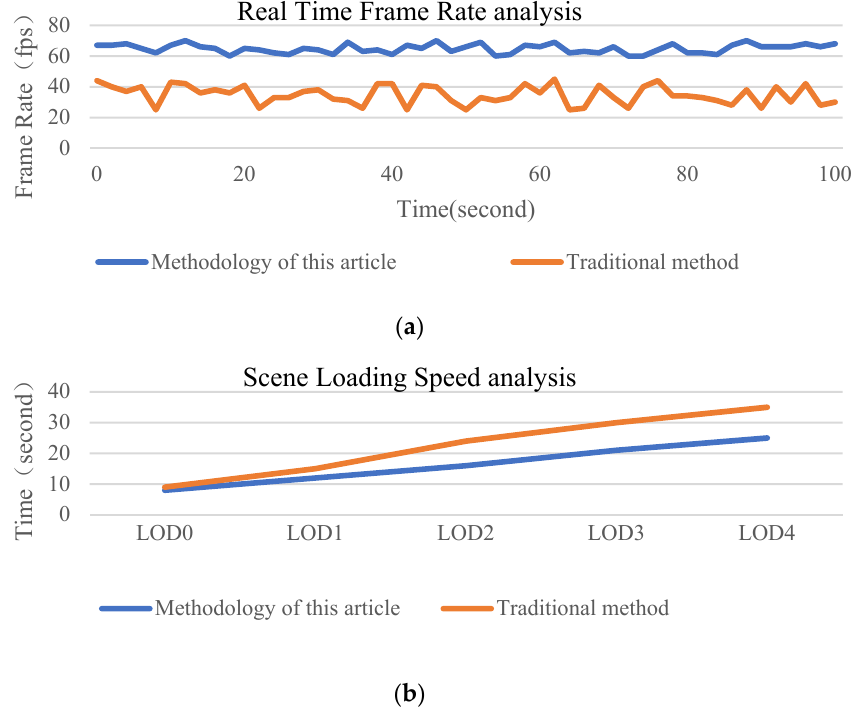
Figure 9. Quantitative comparative analysis: ( a ): The symbolic 3D railway scene data constructed by this research method had a higher frame rate after loading. Scene fluency was optimised. The user experience was improved. ( b ): Under the multi-scale constraint of this research method, the loading of geographic entities with focused features was faster. Moreover, the advantage became more obvious as the LOD level gradually increased. It improved the perceived depth of the user.